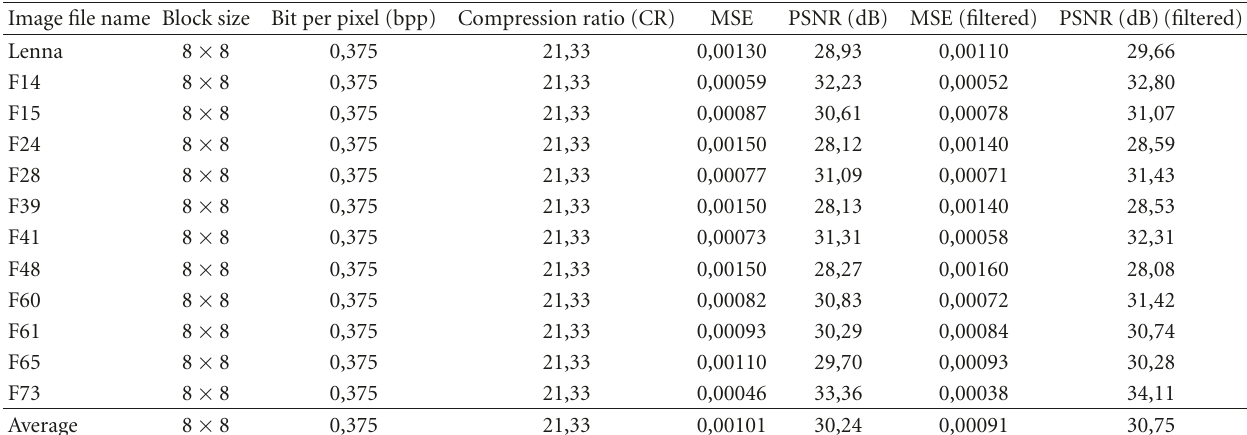
Table 3: Evaluation results of Fold 1.